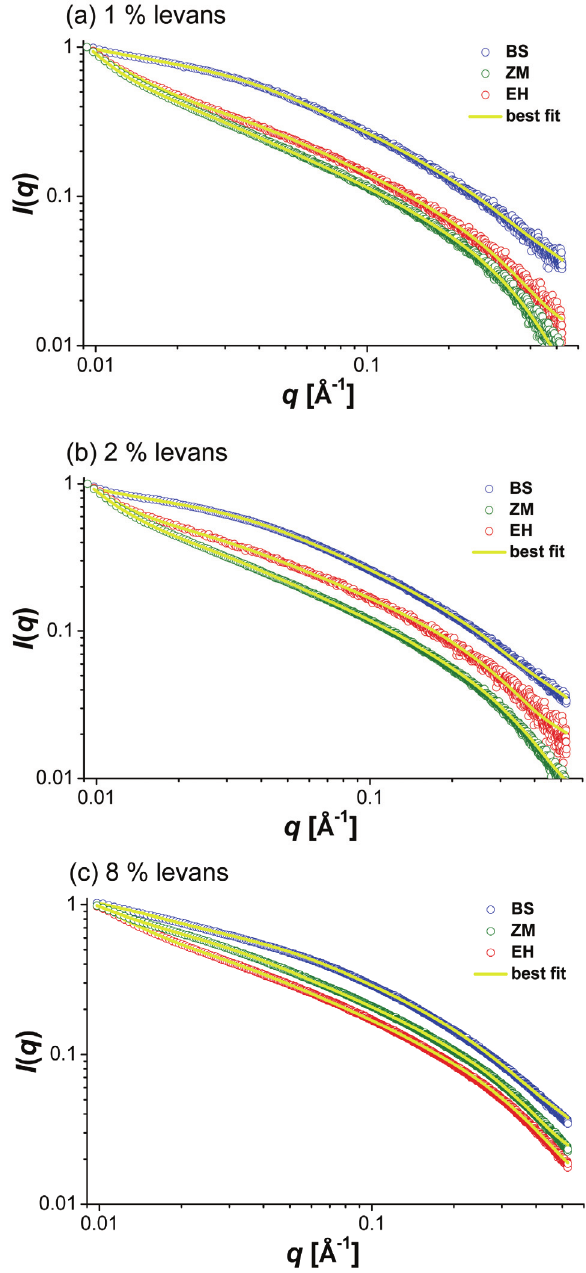
Figure 2: Log-log plots of experimental SAXS curves (open sym- bols) of (a) 1 wt % BS ( (cid:2) ), ZM ( (cid:2) ), and EH ( (cid:2) ) levan, (b) 2 wt % BS ( (cid:2) ), ZM ( (cid:2) ), and EH ( (cid:2) ) levan, and (c) 8 wt % BS ( (cid:2) ), ZM ( (cid:2) ), and EH ( (cid:2) ) levan. The solid lines represent best fits to the da- ta by the string-of-beads model according to